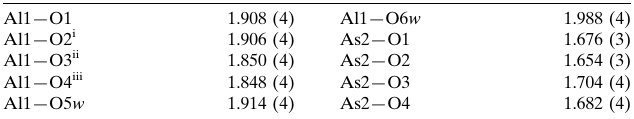
Selected bond lengths (A˚ ).